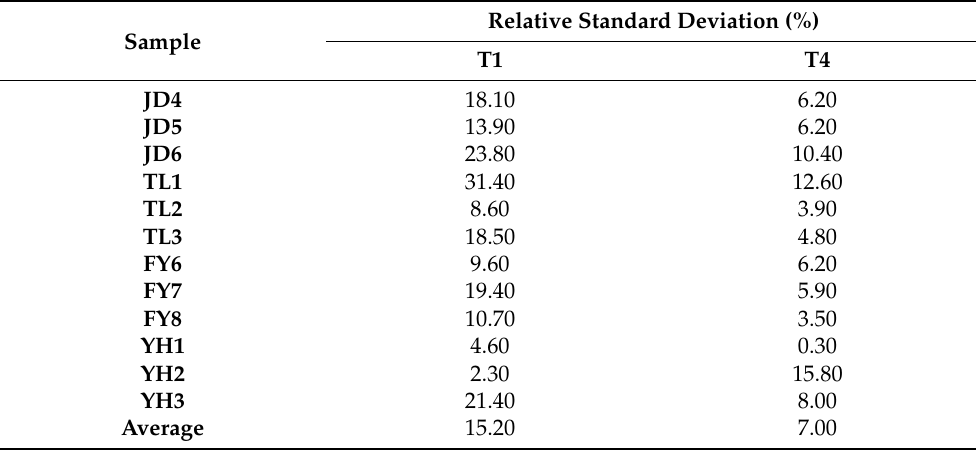
Table 6. Precision of indophenol blue colorimetry and kit method ( n = 5).